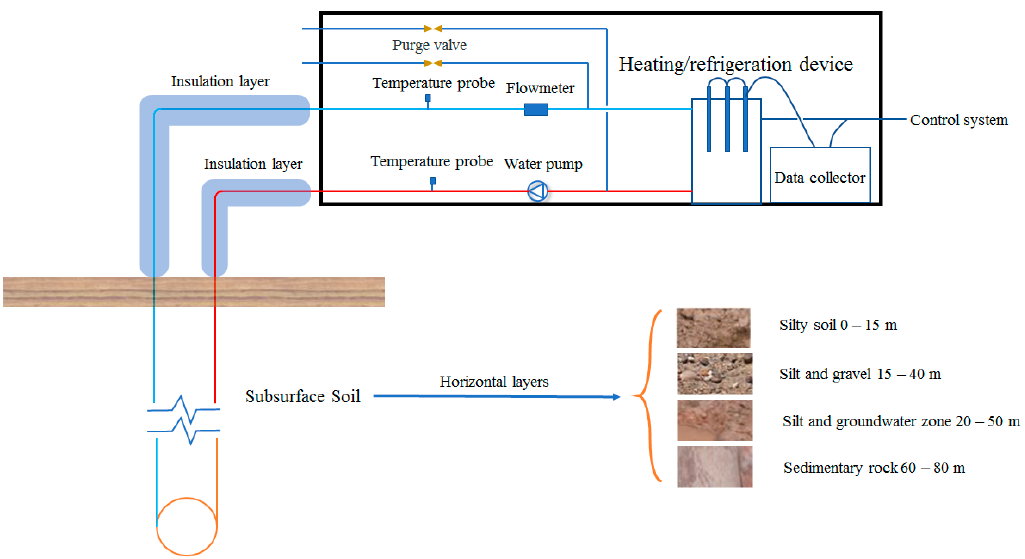
Figure 2. Schematic of the thermal response test.